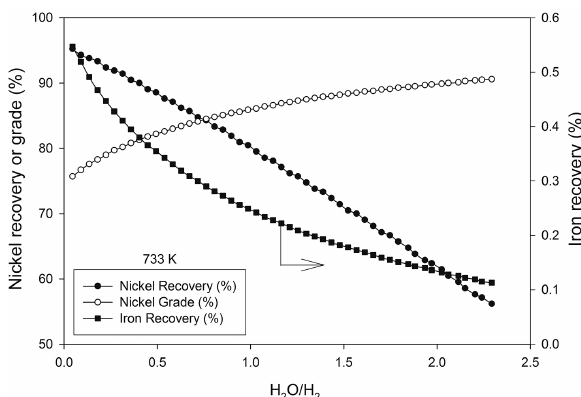
Figure 9: Effect of H 2 O/H 2 ratio on the nickel grade of the ferronickel and also the nickel recovery at 733 K in hydrogen at a reductant to ore ratio of 0.558 kmol/100 kg. Also included is the iron